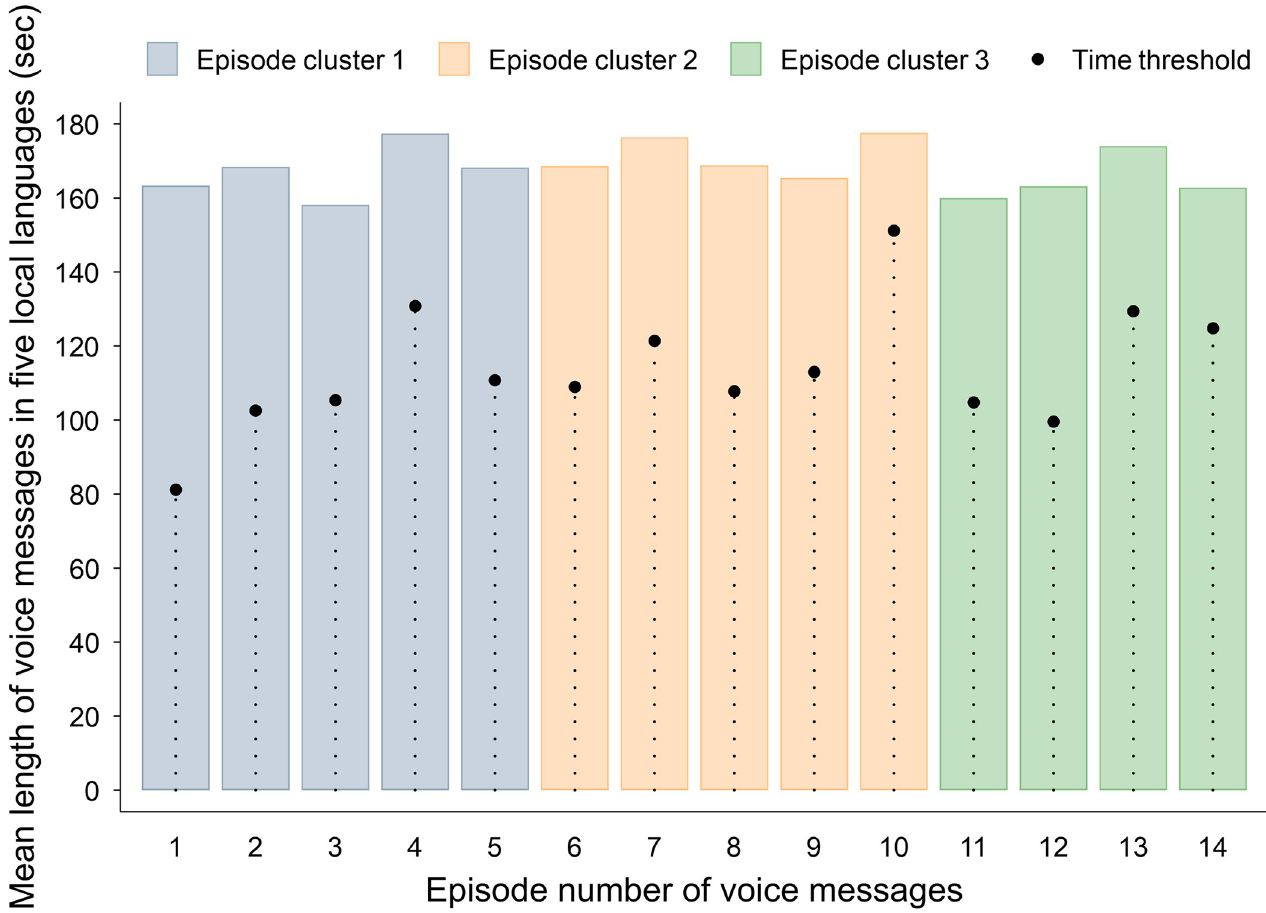
Fig 2. Mean length of voice messages and time threshold in five local languages by episode number.